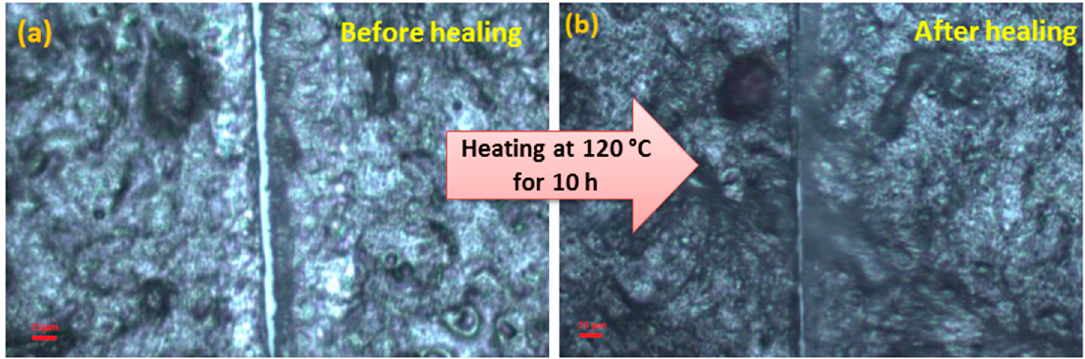
Figure 11. Optical microscope images of ( a ) initial cut sample PMF / BM / CNFs films. ( b ) Healed images of PMF / BM / CNFs films after 10 h heating at 120 ◦ C (Scale bar is 25 µ m). Figure 10. DSC plot of pristine PMF-20 and PMF/CNFs/BM DA-crosslinked adduct.